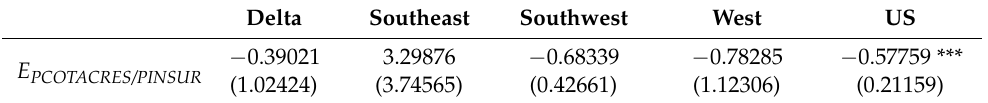
Table 5. Elasticity of percentage of cropland planted to insurance participation. Delta Southeast Southwest West US E